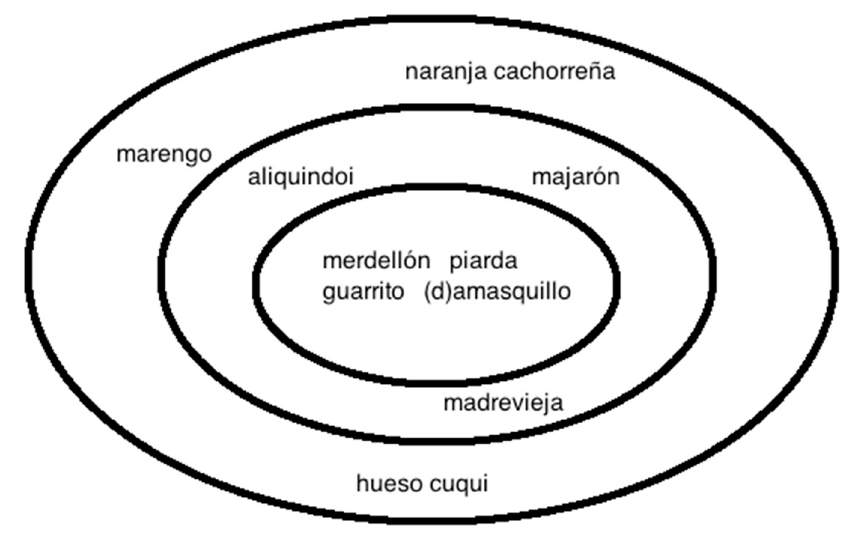
Figure 2. Representation of a sample of the local lexicon of Malaga based on concentrical waves according to frequency of use (Ávila-Muñoz 2017). Table 1. Gloss of the localisms in Figure 2.